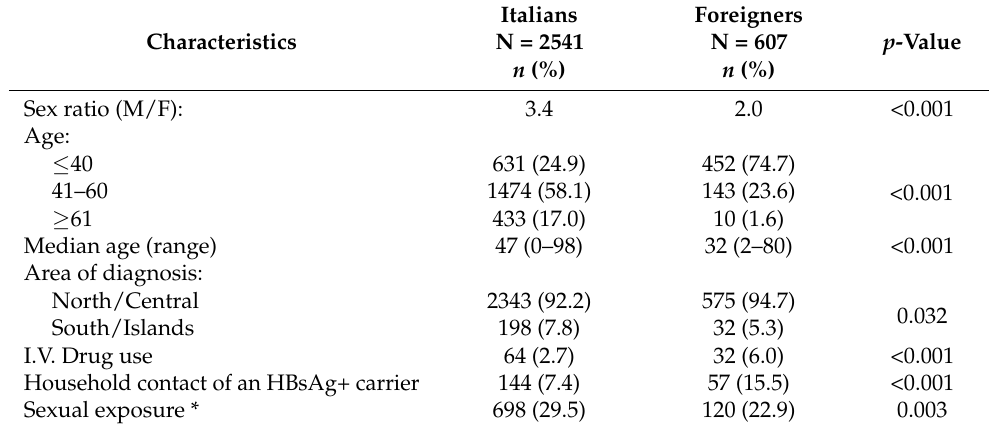
Table 3. Comparison of acute hepatitis B cases in Italy by area of birth. SEIEVA 2010–2019.